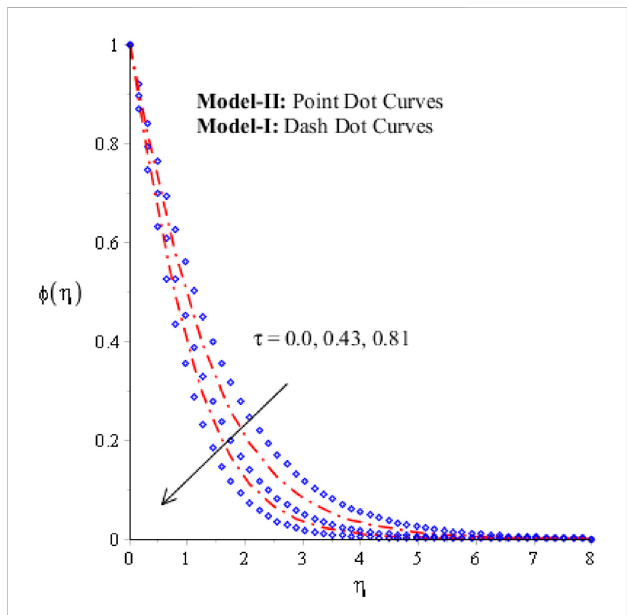
FIGURE 10 Effect of τ on concentration curves when α (cid:2) 3 . 0 , m (cid:2) 0 . 2 , Re (cid:2) 6 . 0 , We (cid:2) 4 . 0 , γ (cid:2) 0 . 2 , β (cid:2) 1 . 6 , Λ (cid:2) 0 . 3 , Pr (cid:2) 5 , ϵ (cid:2) 0 . 1 , H t (cid:2) − 2 . 0 , Sc (cid:2) 1 . 5 , λ (cid:2) 0 . 3 , K c (cid:2) 2 . 0 , and χ (cid:2) 0 .